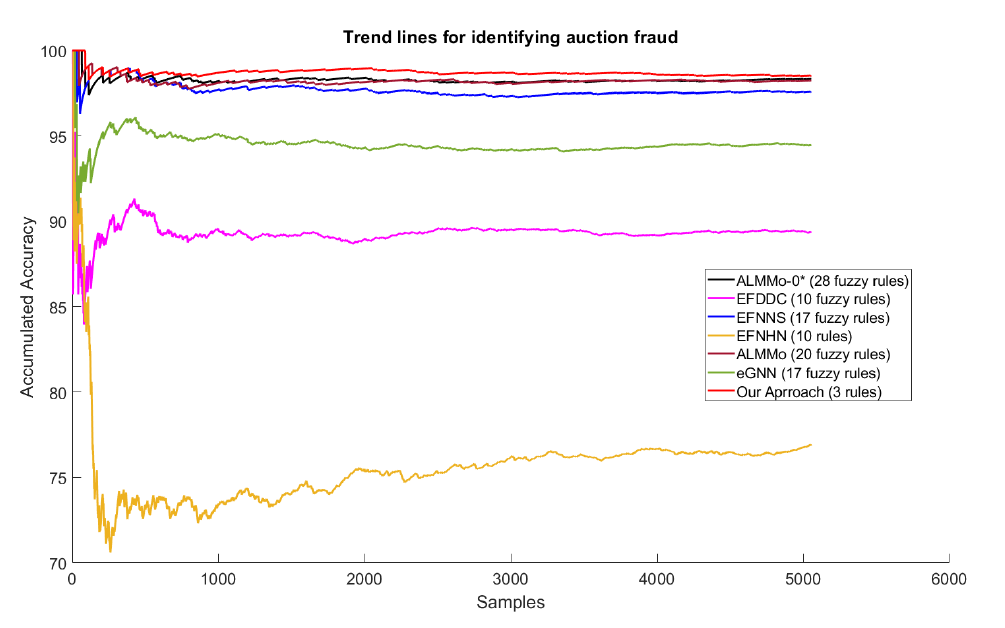
Figure 8. Trend lines for the Auction Fraud